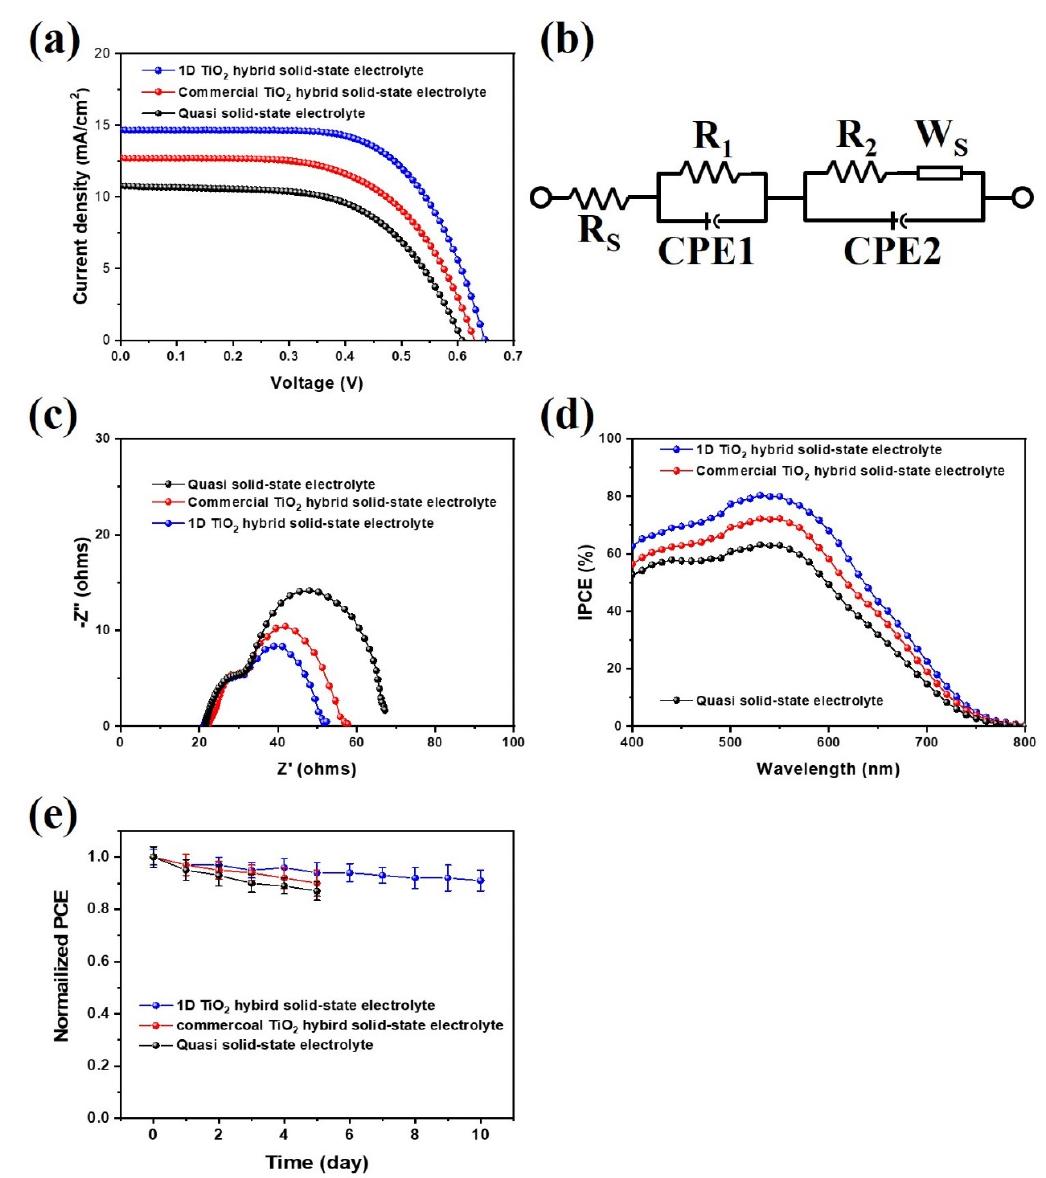
Figure 6. ( a ) J-V curves, ( b ) equivalent circuit diagram, ( c ) Electrochemical impedance spectroscopy (EIS) Nyquist plots, and ( d ) Incident photo-to-electron conversion efficiency (IPCE) curves of mesoporous carbon-based DSSCs fabricated with quasi solid-state electrolyte, commercial TiO 2 hybrid solid-state electrolyte, and 1D TiO 2 hybrid solid-state electrolyte at 100 mW/cm 2 . ( e ) Normalized cell efficiency of the mesoporous carbon-based DSSCs with 1D TiO 2 hybrid solid-state electrolyte (40–50% relative humidity). Error bars represent the standard deviation of at least 5 cells.